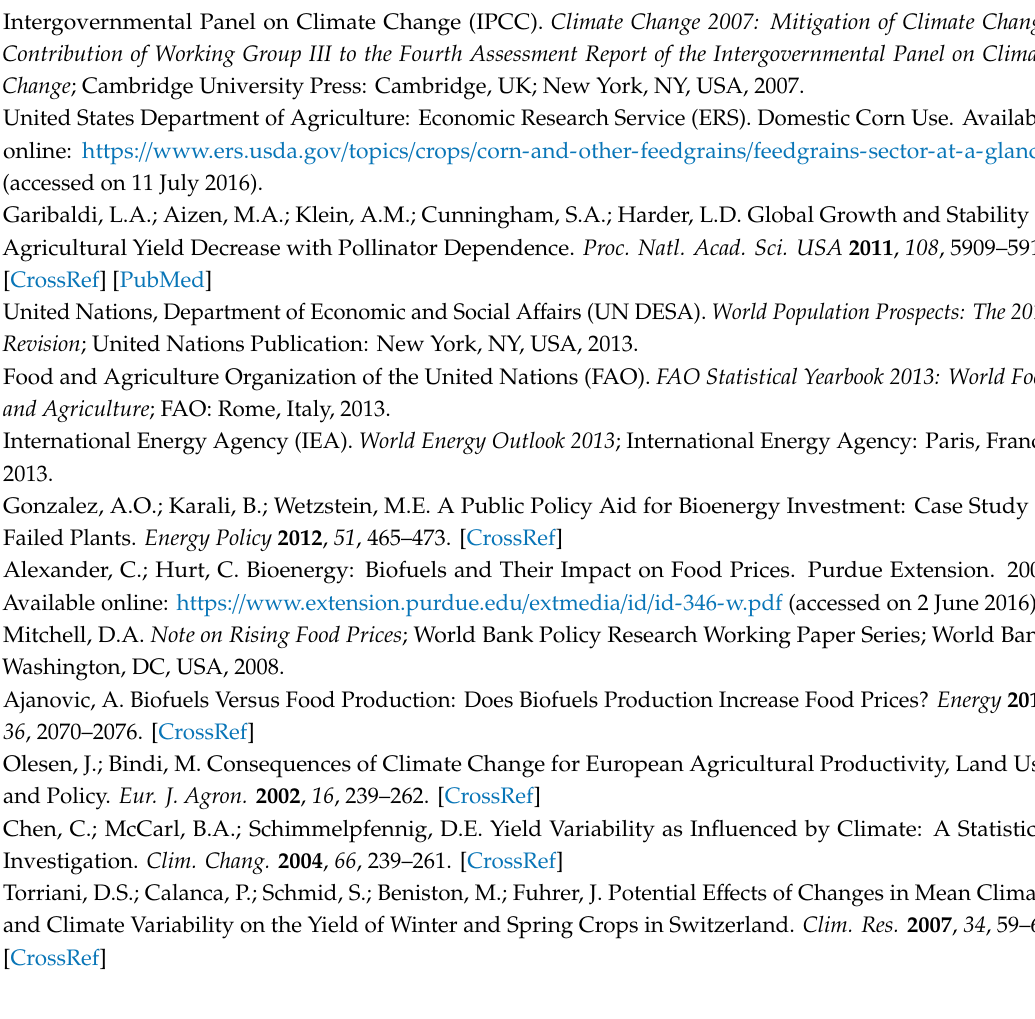
Figure A3. Variability of U.S. cropland pasture used for livestock (in million acres) stochastic draw during 2015 to 2030 under various biofuel policy and demand growth scenarios.